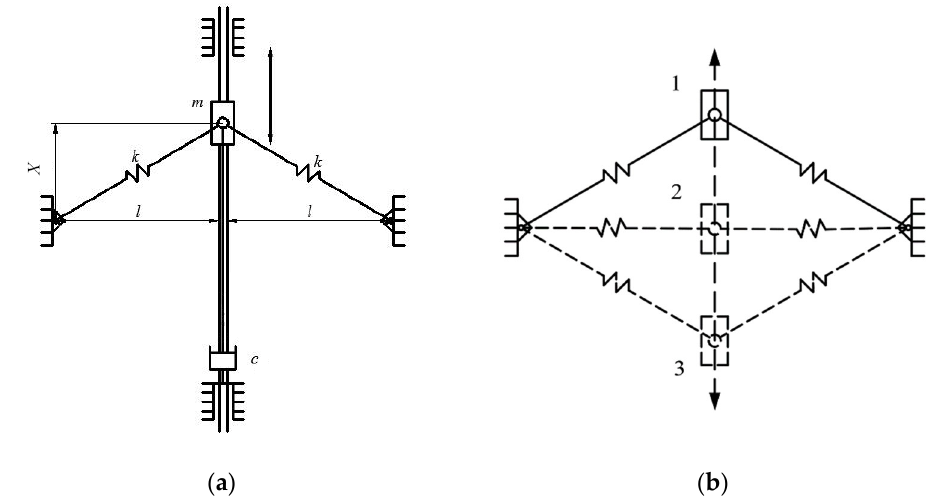
Figure 1. ( a ) The prototypical SD oscillator model; ( b ) the schematic diagram of stable positions of the SD oscillator.